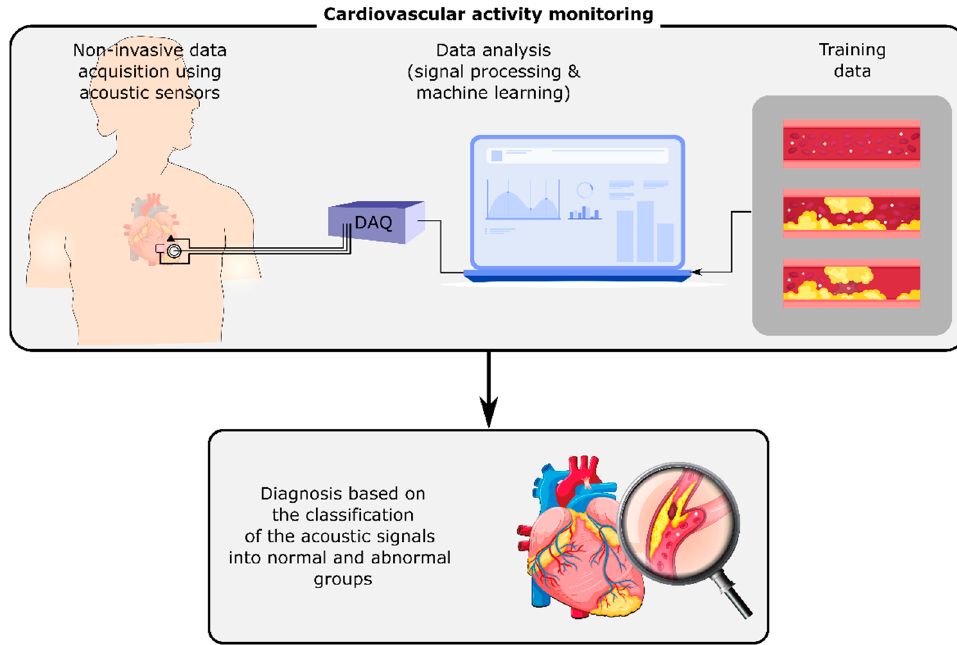
Figure 1. Cardiovascular activity monitoring using the non-invasive measurement of acoustic signals on the chest’s surface. The analysis of these signals using digital signal processing and machine learning methods can identify cardiovascular conditions such as stenosis and aneurysm.